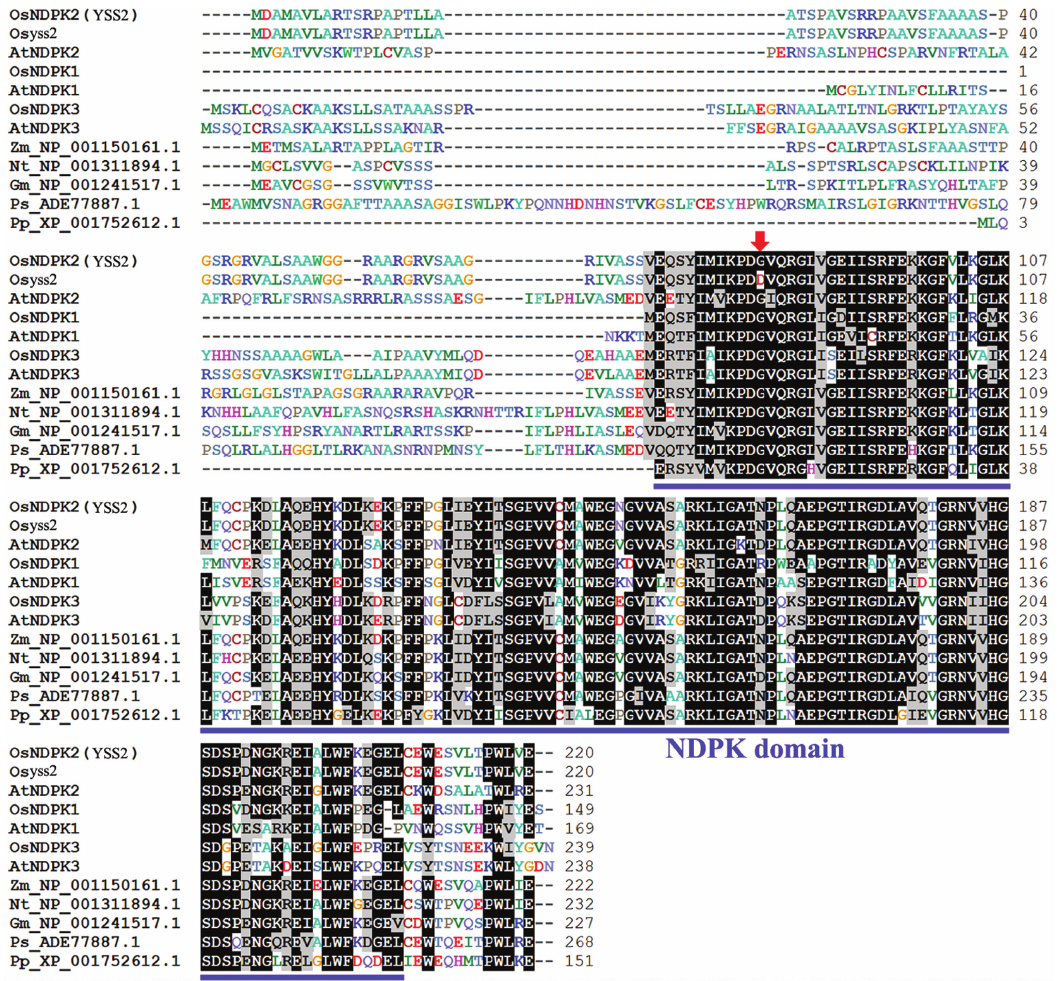
Figure 3 - Amino acid sequence alignment of YSS2-related proteins. Conserved residues are shaded. Sequences are for OsNDPK2/YSS2 ( Oryza sativa , LOC_Os12g36194), Osyss2 (the mutated YSS2 protein), AtNDPK2 ( Arabidopsis thaliana , At5g63310), OsNDPK1 ( Oryza sativa , LOC_Os07g30970), AtNDPK1 ( Arabidopsis thaliana , NP_567346.1), OsNDPK3 ( Oryza sativa , LOC_Os05g51700), AtNDPK3 ( Arabidopsis thaliana , At4g11010), Zea mays NP_001150161.1, Nicotiana tabacum NP_001311894.1, Glycine max NP_001241517.1, Picea sitchensis ADE77887.1, Physcomitrella patens XP_001752612.1. Blue underlining represents the NDPK domain of NDPK-related proteins. A red arrow indicates the substituted amino acid in yss2.